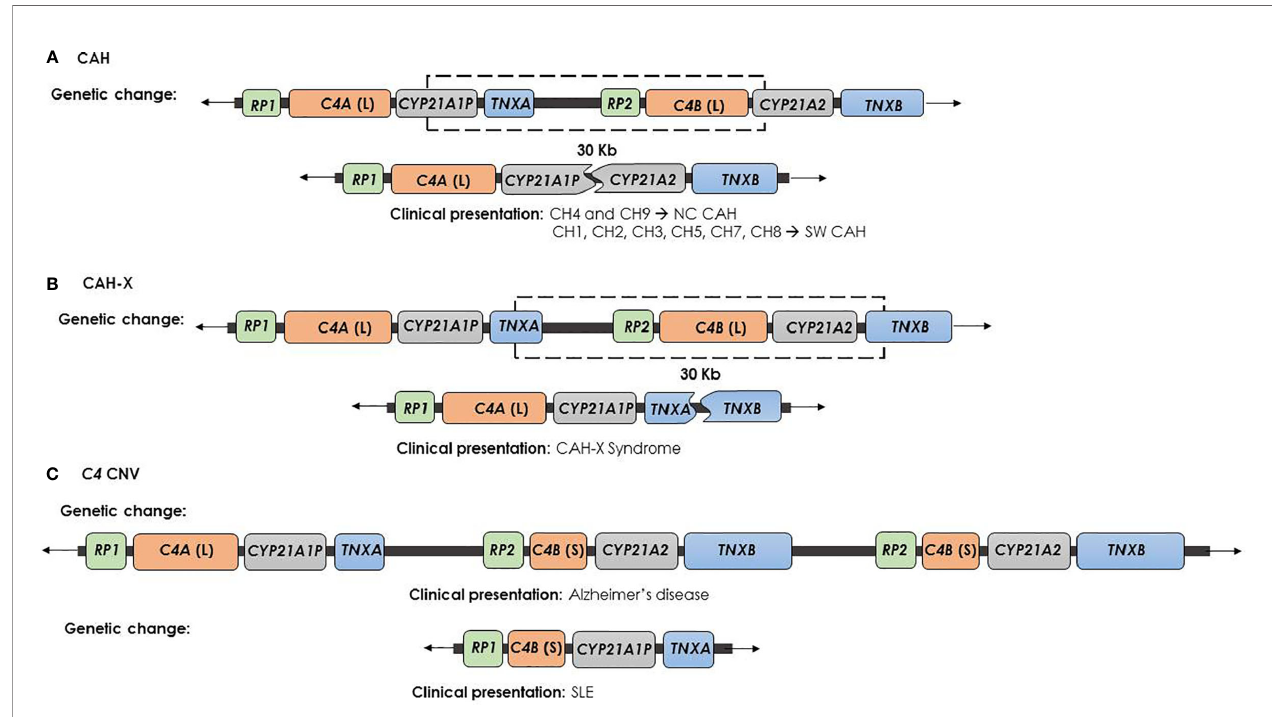
FIGURE 2 | Genetic changes and clinical presentation. (A) CAH chimera ( CYP21A1P / CYP21A2 ) is caused by recombination between CYP21A1P and CYP21A2 and causes the impairment of CYP21A2 and the deletion of C4B , but leaves safe the TNXB gene. CH-1, CH-2, CH-3, CH-5, CH-6, CH-7 and CH-8 chimeras are involved in the severe SW form of CAH. In contrast, CH-4 and CH-9 chimeras are generally related to a milder phenotype. (B) CAH-X chimera ( TNXA / TNXB ) is caused by recombination between TNXA and TNXB and produces the complete deletion of CYP21A2 gene, the impairment of TNXB gene and the deletion of C4B . This contiguous deletion is termed CAH-X and causes CAH-X syndrome. (C) Psychiatric and autoimmune diseases due to C4 CNV: the high C4B copy number has been described as Alzheimer ’ s disease risk factor, while the C4A de fi ciency was related to